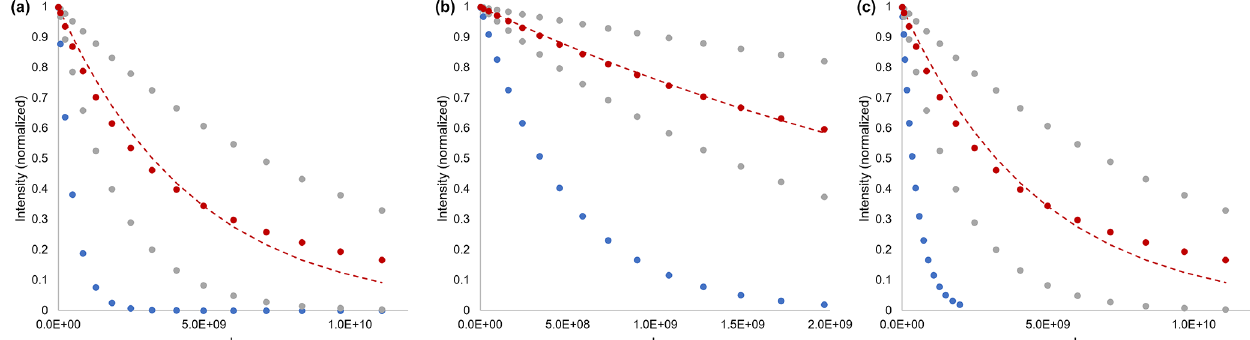
Figure 4. Simulated data to demonstrate the distinction between a fast-diffusing mixture component and a slow-diffusing mixture component experiencing restriction. (a) Gradient strength sufficient to observe multicomponent decay (failure of single exponential fit – red), but not optimized for the fast component (blue). (b) Gradient strength optimized for fast-diffusing species (blue) but not sufficient to identify multi- component diffusion (red). (c) Single experiment and gradient strength optimized independently for fast- and multicomponent species. Dashed lines are fits to the diffusion equation (Eq. 1), assuming a single exponential decay. The red dots are the sum (50:50) of two single exponential decays (grey). Simulated D = 2 × 10 − 9 m 2 s − 1 (blue), 5 × 10 − 10 m 2 s − 1 , and 1 × 10 − 10 m 2 s − 1 (grey), with G = 260.8Gcm − 1 , δ = 2ms, (cid:49) = 250ms, and τ =